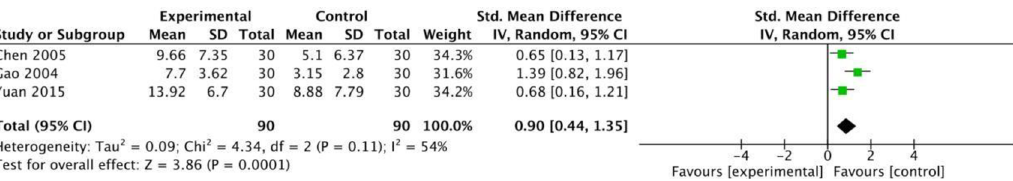
Fig 12. Meta-analysis of fire acupuncture versus acupuncture for spasticity after stroke in NDS.